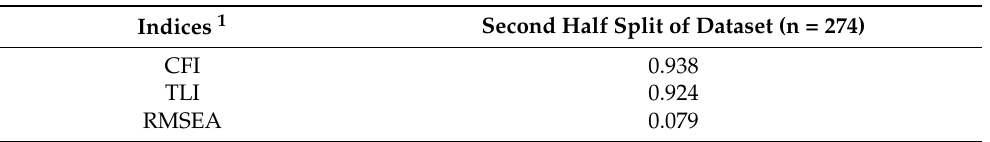
Table 7. CFA results (second half split of dataset)—goodness of fit for the three-factor model of the EDE-Q suggested by EFA (first half split of